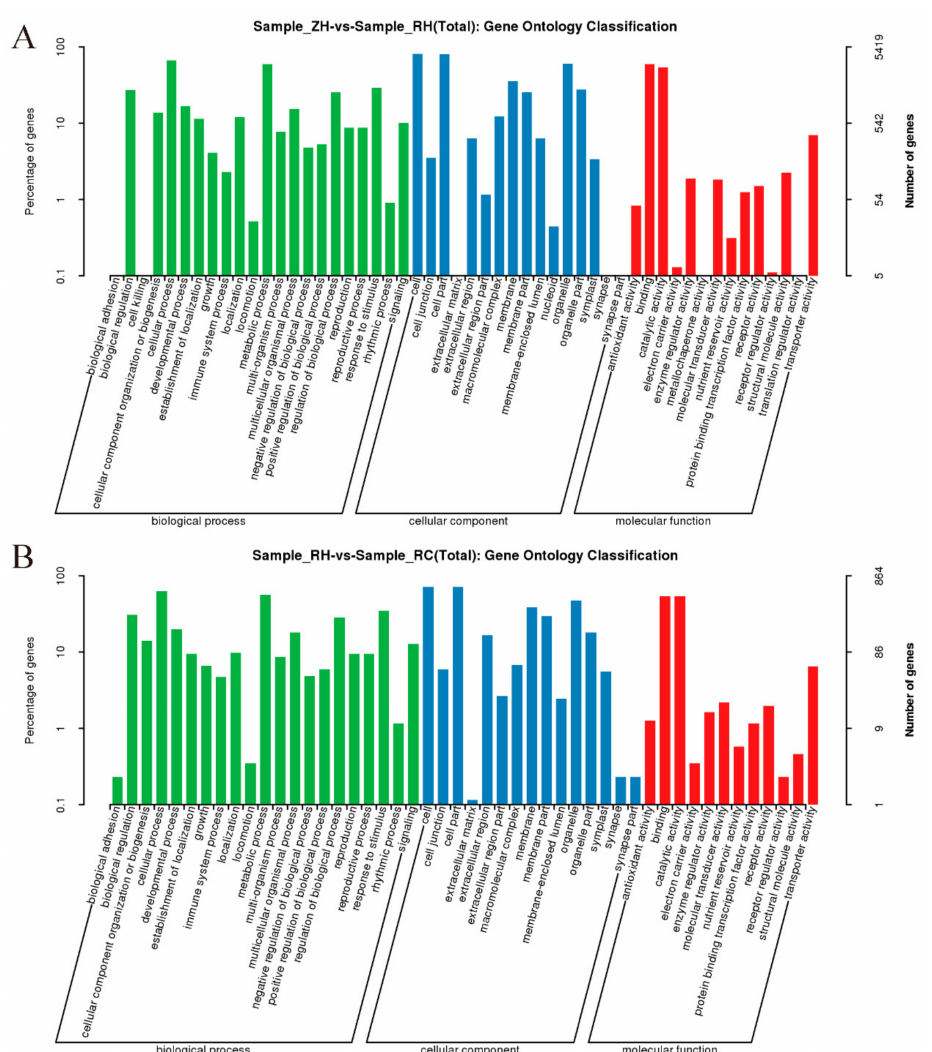
Figure 5. Scatter plot of the GO terms for the DEGs. ( A ) GO analysis of ZH vs. RH. ‘Percentage of gene’ is the ratio of the DEGs to the background number in the given GO classification. Go classification of DEGs enriched under weak light. ( B ) GO annotation classification of potatoes with weak light by exogenous Ca 2 +